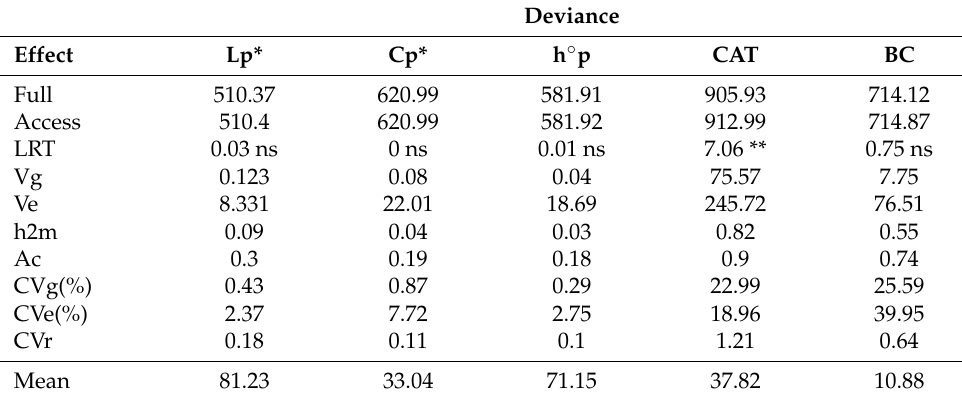
Table 2. Estimates of the variance components for the quantitative characteristics of pulp, lightness (L*), saturation (C*), hue (h ◦ ), total carotenoids (CAT), and β -carotene (BC) in 23 accessions and 2 cultivars of C. maxima. Mossor ó -RN, 2020.